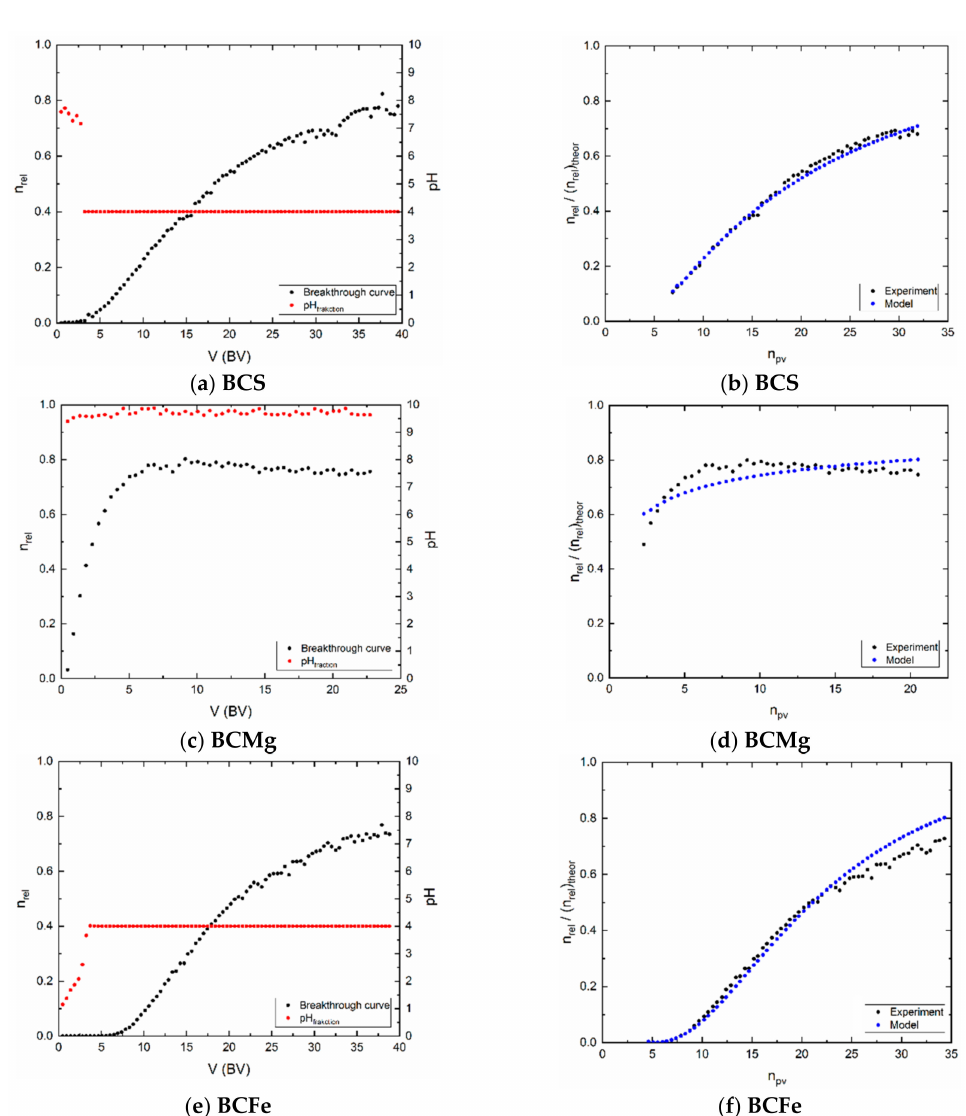
Figure 5. Left ( a , c , e ): Experimental breakthrough curves and actual pH of each fraction; Right ( b , d , f ): experimental breakthrough and the